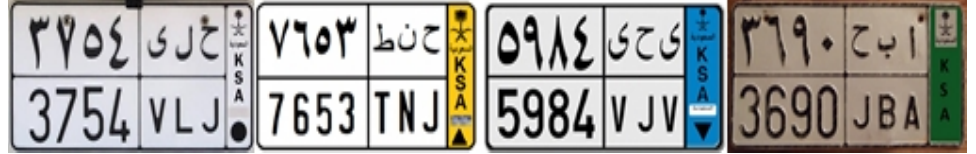
Figure 2. Types of Saudi Arabian license plates [34].